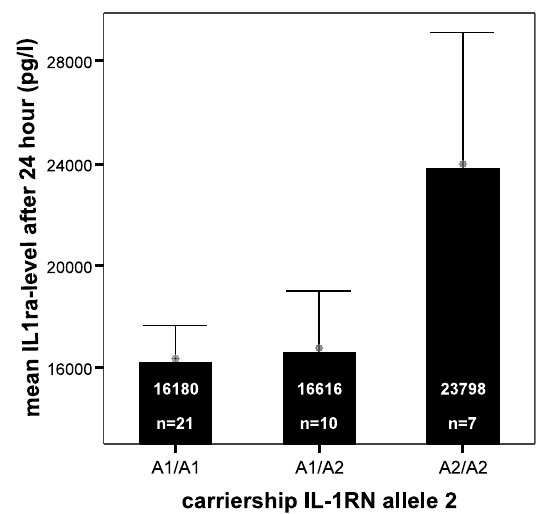
FIG. 3. Mean IL-1ra levels after 24 h and IL-1RN allele 2 number. Error bars represent standard error of mean; n, number of individuals; A1/A1, non-carriers of IL-1RNallele 2; A1/A2, carriers of one copy of IL-1RNallele 2; A2/A2, carriers of two copies of IL-1RN allele 2. pP (cid:4) / 0.043 A2/A2 versus other genotypes.